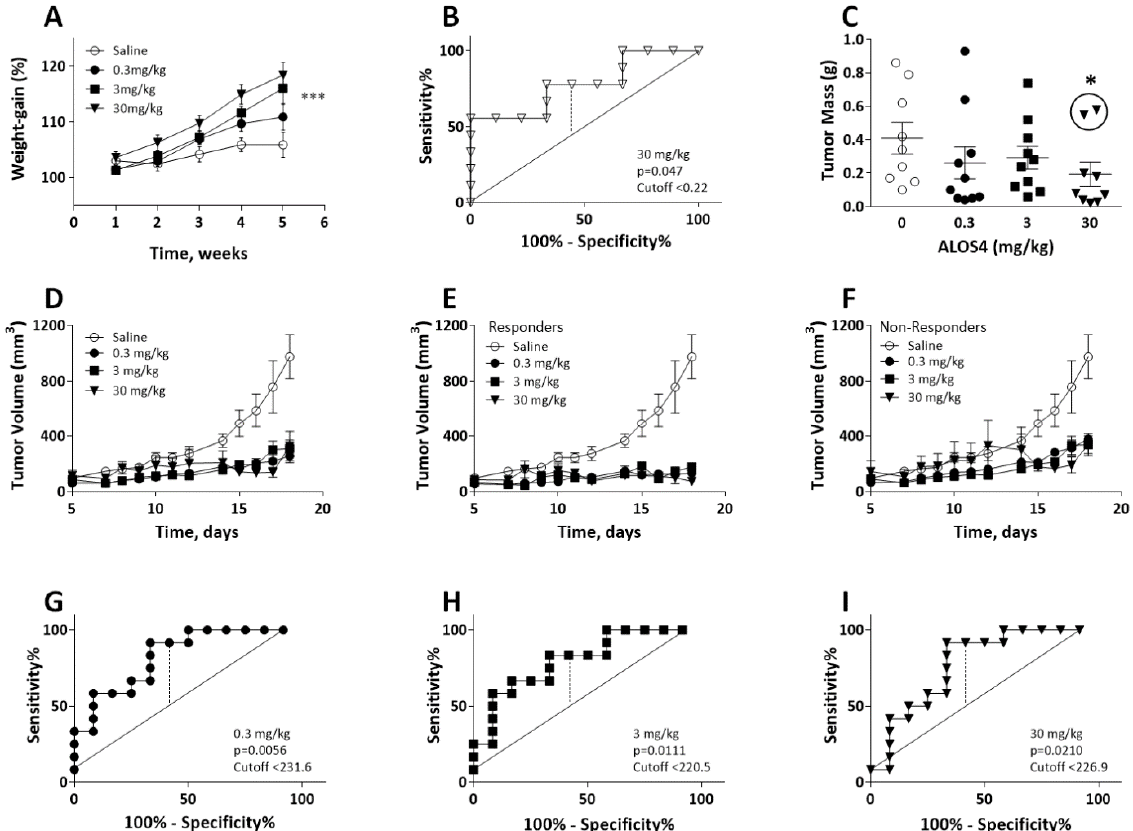
Figure 1. Effect of ALOS4 on body weight and tumor volume in SC A375 human melanoma mouse model. ( A ) Differences in the body weight gain of the nude mice inoculated with xenograft A375 SC tumor after 5 weeks administration with 0.3, 3, or 30 mg/kg of ALOS4. ( B ) ROC analyses of 30 mg/kg ALOS4-treated mice to determine threshold for positive drug response (Youden’s Index) at day 18 ( n = 10). ( C ) Tumor mass (g) with two excluded (circled) non-responder mice based on ROC cutoff value. *, Dunn’s test p < 0.05. ( D – I ) ROC Analysis of responders and non-responders to ALOS4 treatment in SC A375 model. ( D ) Tumor volume growth in all treated nude mice. ( E ) Saline and ALOS4-treated responders only. ( F ) Saline and ALOS4-treated non-responders only. ( G – I ) ROC analyses of ALOS4-treated mice to determine threshold for positive drug response (Youden’s Index). * p < 0.05; *** p < 0.001. ( n = 8).